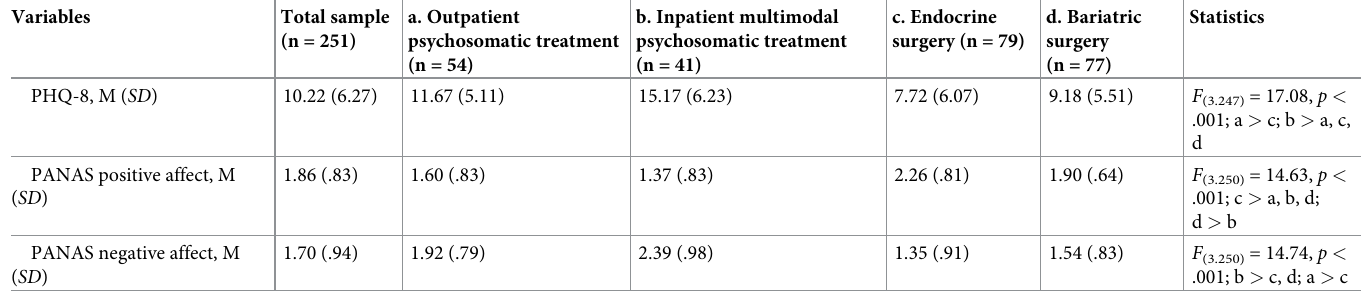
Confirmation sample. The confirmation sample consisted of 303 patients (36% female, mean age 62.1 years ( ± 13.9)) undergoing treatment for different types of cancer. The most fre- quent cancer types were urogenital 30.4%, dermatological 22.1%, head-neck 16.5%, and lung 13.9%. The most frequent procedures were awaiting or undergoing chemotherapy (34.7%), further diagnostic examination (26.4%) or surgery